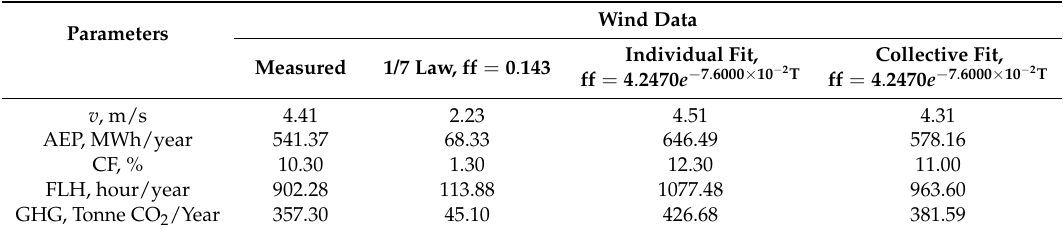
Table 11. Wind resource and energy yield parameters calculated at 70 m by the Langkawi site using a single 600-kW rated power Dewind D4/48-600 wind